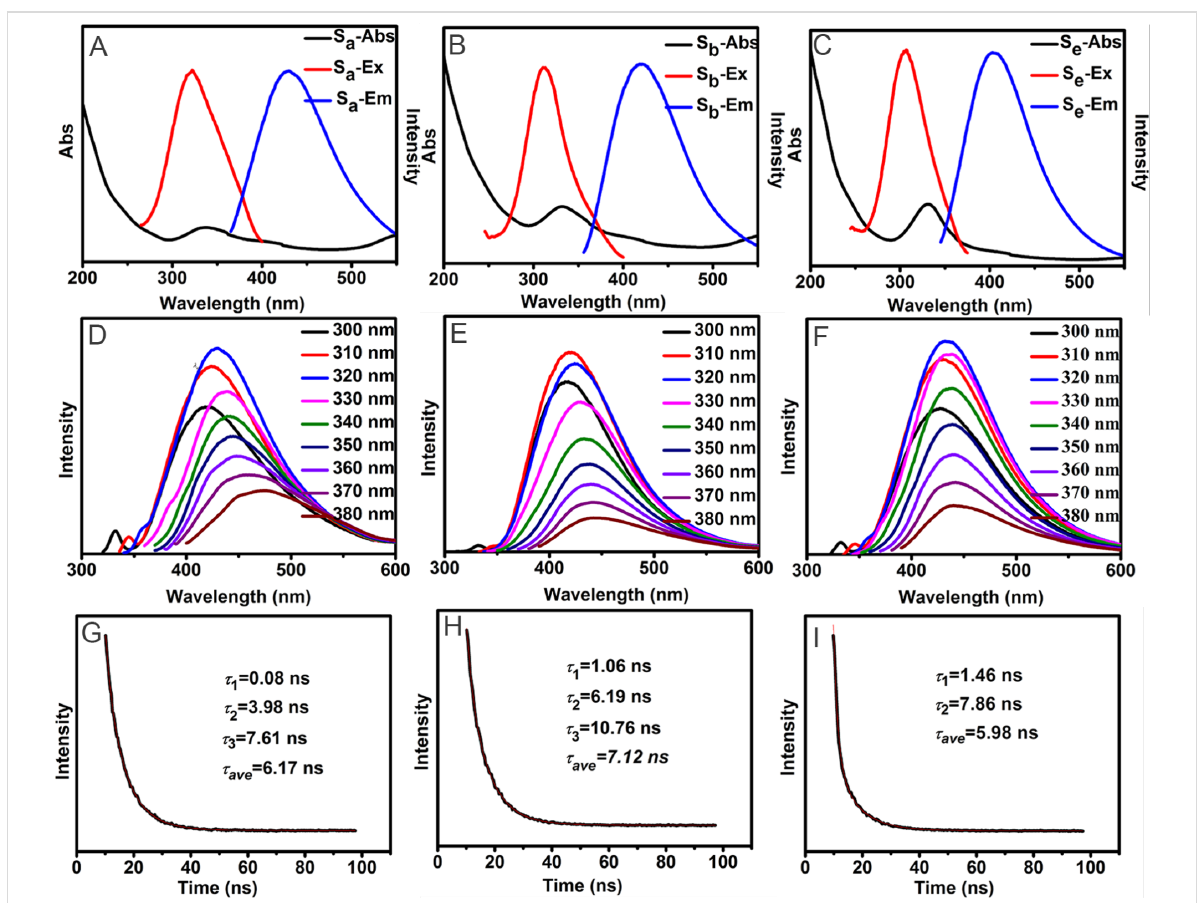
Figure 2: (A–C) UV–vis absorption, excitation and emission spectra, (D–F) fluorescence emission spectra recorded at different excitation wave- lengths and (G–I) fluorescence intensity decay curves of S a , S b and S e , respectively .